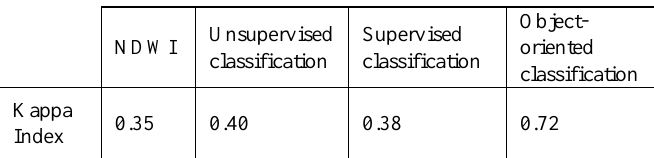
Table 3. Kappa Index Evaluation